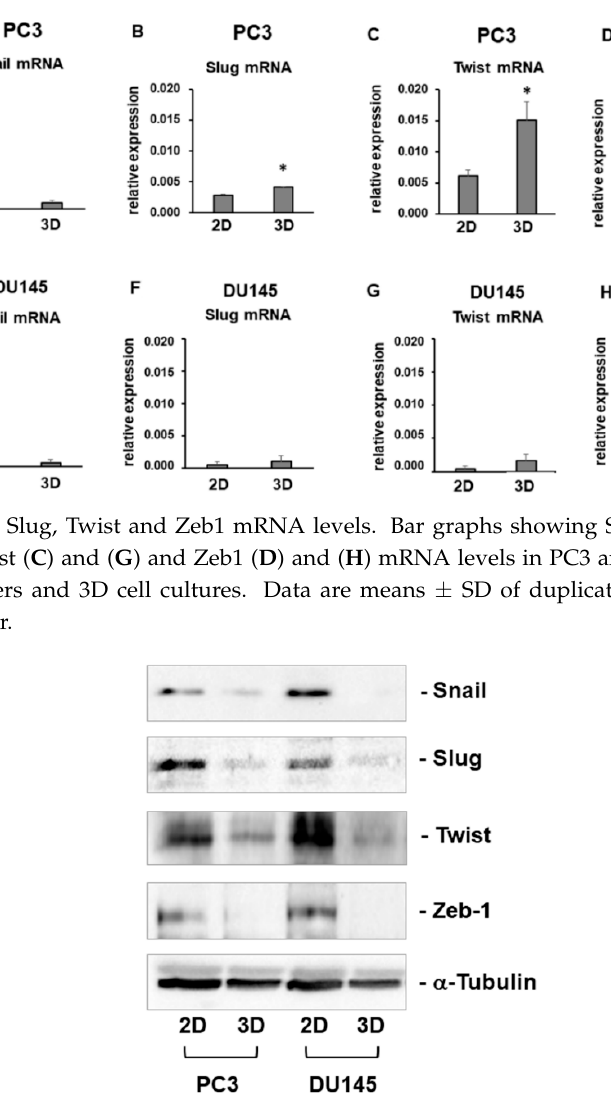
Figure 7. Snail, Slug, Twist, and Zeb1 protein levels. Representative Western blot analysis showing Snail, Slug, Twist, and Zeb1 protein levels in whole cell lysates obtained from PC3 and DU145 cells cultured in 2D-monolayers and 3D cell cultures.